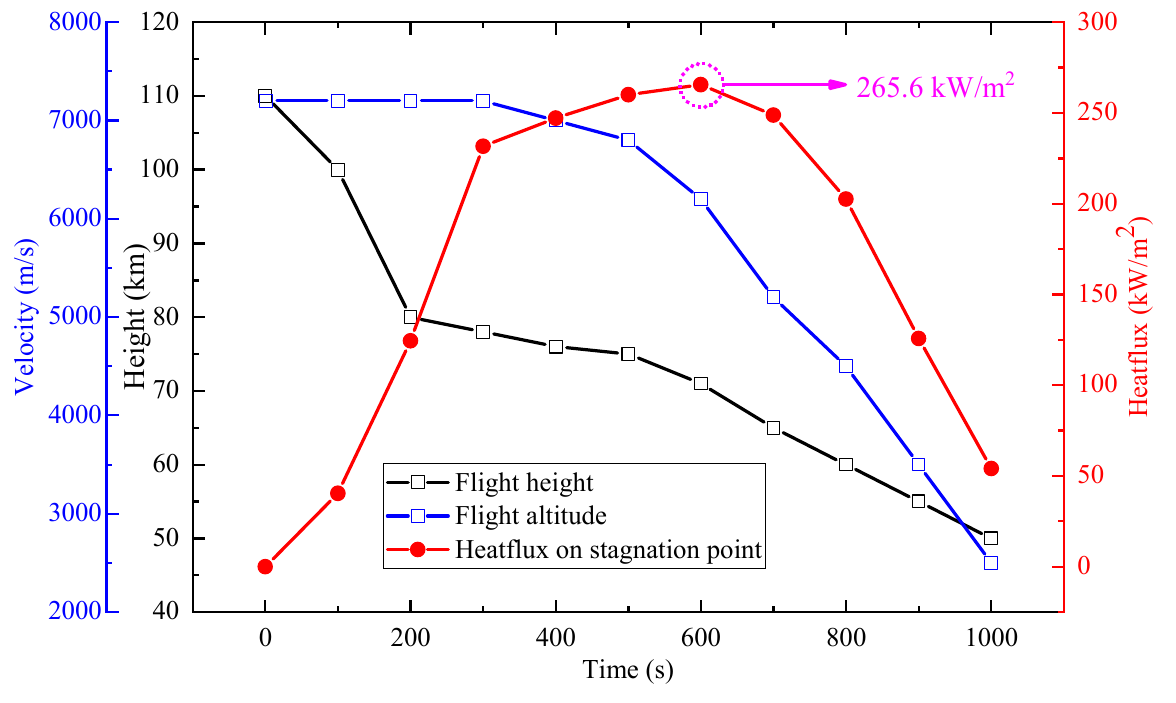
Figure 5. The heat flux on the stagnation point over the whole trajectory.